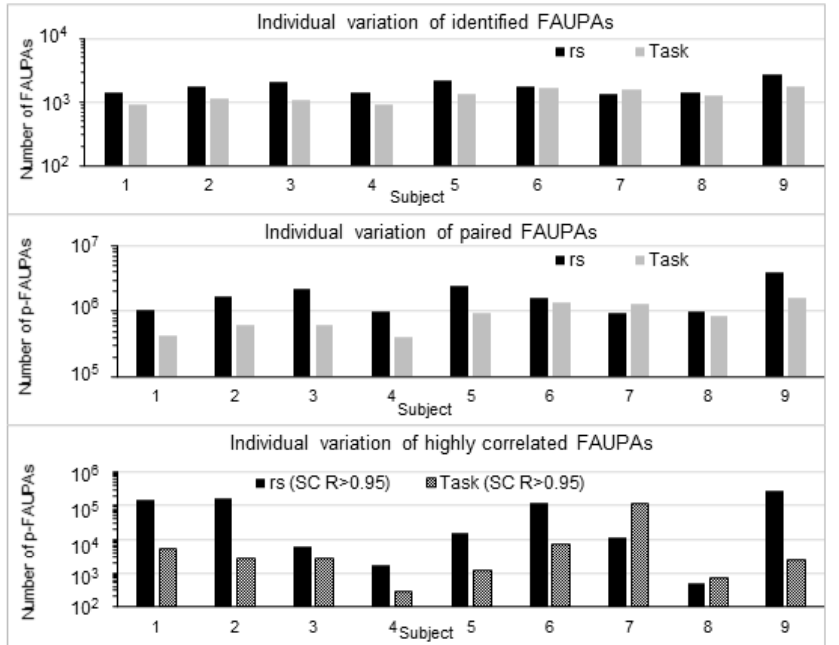
Figure 4. Illustration of individual variation of the identified FAUPAs and highly correlated FAUPAs for both resting and task states of each subject. Top panel: the total number of FAUPAs ranged from 903 to 1784 with mean ± standard deviation (SD) = 1309 ± 320 for the task state and from 1373 to 2804 with mean ± SD = 1818 ± 480 for the resting state (RS), respectively. Middle panel: the total number of all pairwise combinations of N FAUPAs is equal to N × (N − 1)/2. p-FAUPAs: paired FAUPAs. Bottom panel: individual variation of the total number of paired FAUPAs with the threshold SC R > 0.95. This number ranged from 288 to 116,230 for the task state and from 520 to 280,521 for the resting state, respectively.